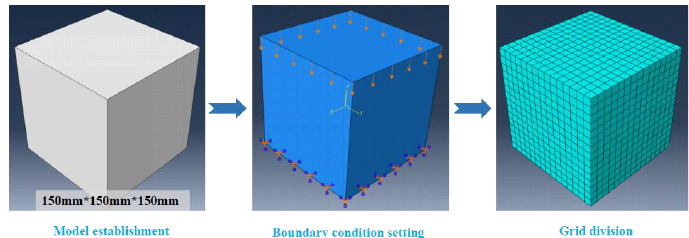
Figure 2. Establishment of concrete block model based on Abaqus.